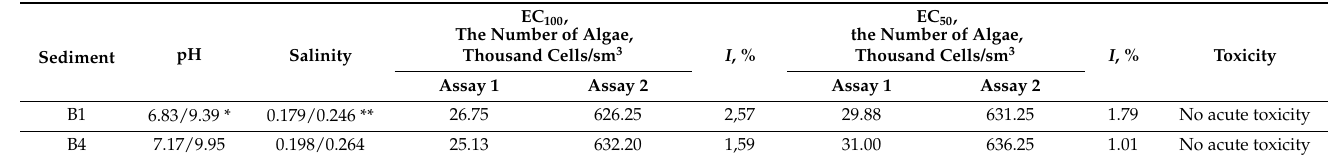
Table 9. Results of ecotoxicity for the bay sediments samples using Scenedesmus quadricauda